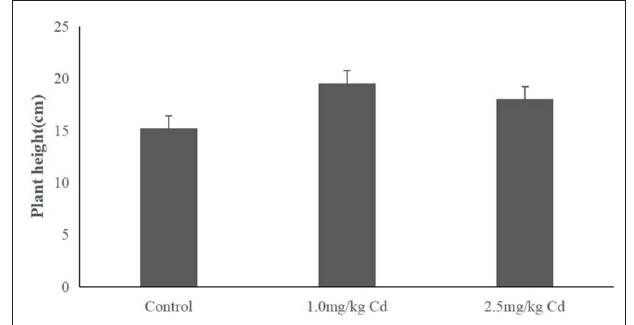
FIGURE 2 | The biomass of different tissues from snapdragons treated with Cd at 0, 1.0, and 2.5